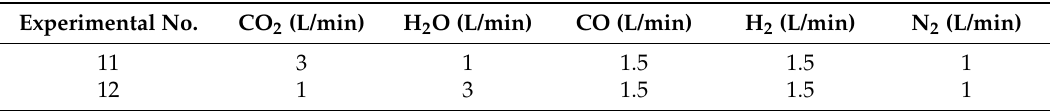
Table 8. Experimental arrangement of bituminous char gasification in the mixture of CO 2 , H 2 O, CO, H 2 , and N 2 .